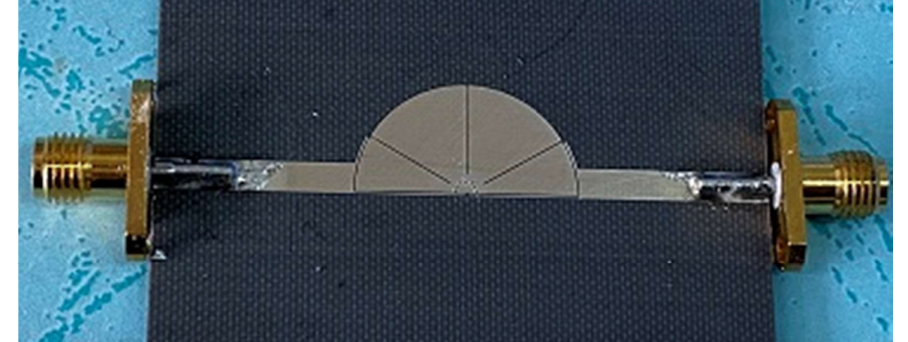
Figure 12. The simulated and measured responses.